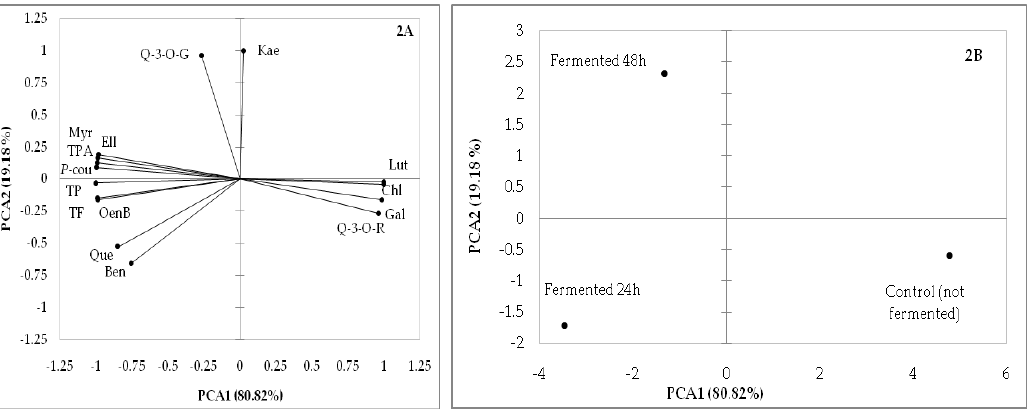
Figure 2. PCA results for the 2017 growing season: ( 2A ) factor loadings for polyphenols (total polyphenols (TP), total flavonoids (TF), quercetin-3- O -rutinoside (Q-3- O -R), myricetin (Myr), luteolin (Lut), quercetin (Que), quercetin-3- O -glucoside (Q-3- O -G), kaempferol (Kae), total phenolic acids (TPA), gallic (Gal), chlorogenic (Chl), p-coumaric (P-cou), ellagic (Ell), benzoic (Ben), oenothein B (OenB)) and ( 2B ) projection of fireweed samples fermented for different durations (control (not fermented), fermented 24 h and fermented 48 h).